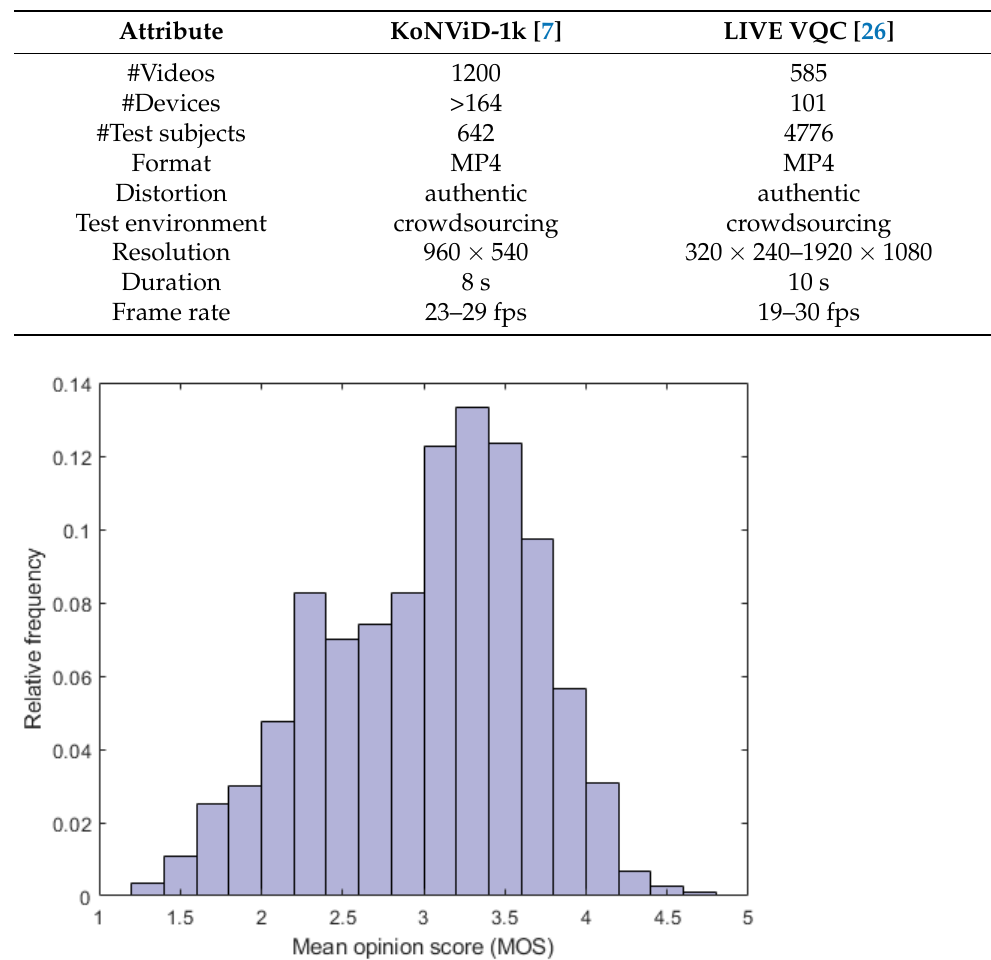
Figure 4. Empirical distribution of MOS in KoNViD-1k [7].